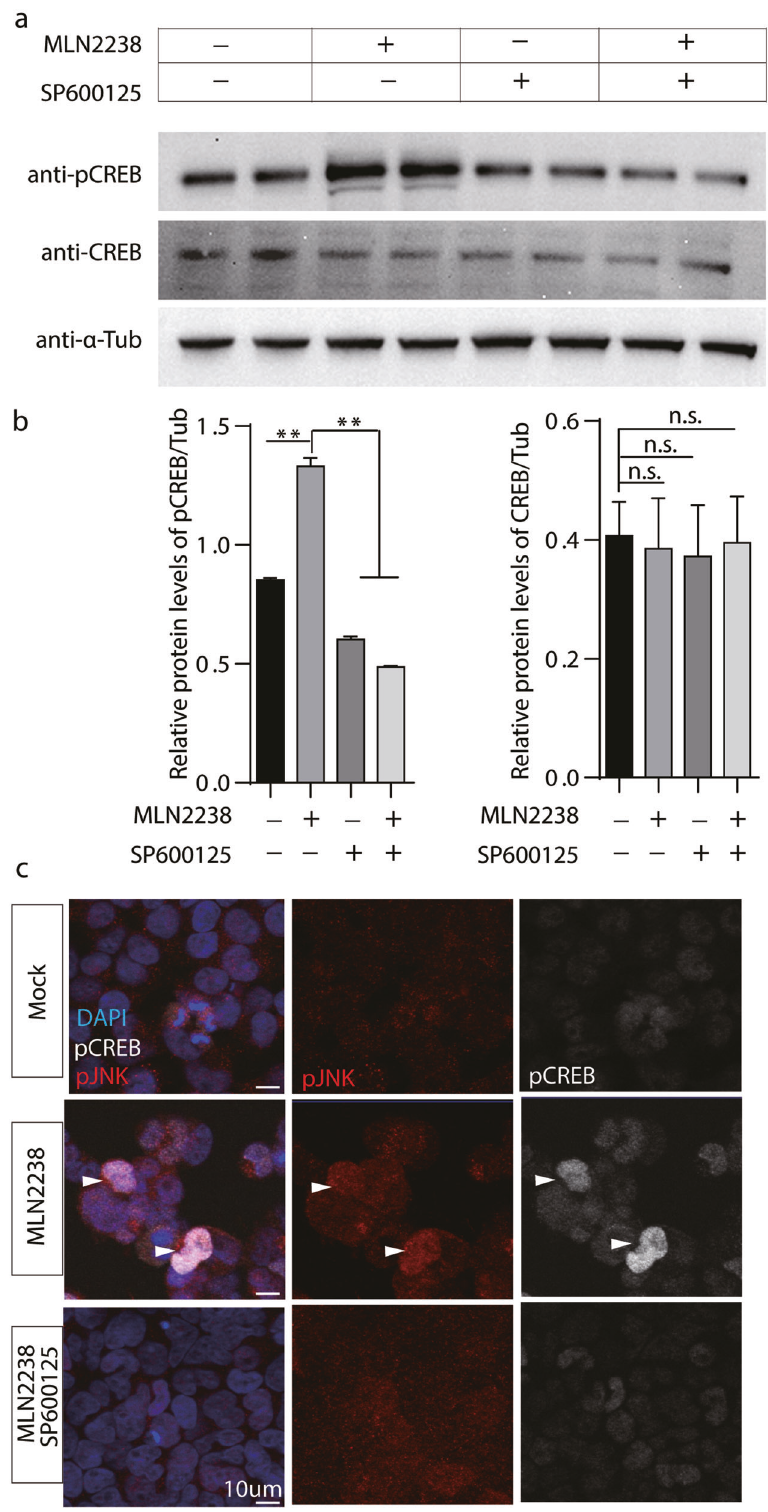
Fig. 5 MLN 2238 activates JNK which is required for CREB activation in 293 T cells. a CREB phosphorylation status (Ser131) in 293 T cells was detected by Western blot. Total protein lysate from control and cells treated with MLN2238 (5 nM) and/or SP600125 (40 uM) for 24 h by immunoblotting using pCREB, CREB and α -tubulin antibodies. Representative blots from three independent experiments are shown. b Relative expression of CREB and pCREB in immuno-blots shown in panel a were quanti fi ed using α -tubulin as internal controls. t -Test was performed for statistical analysis. ** p < 0.01, n.s.: no signi fi cance. c Representative images of immune-staining against phospho-JNK(pJNK at Thr 183 and Tyr 185 ) and phospho-CREB(anti-CREB Ser 133 ) after treat with MLN2238 (5 nM) and/or SP600125 (40 uM) for 24 h in 293 T cells. Separate channels shown on the right. Scale bar: 10um. Arrowhead points to cells accumulated with pCREB and pJNK after MLN2238 treatment.